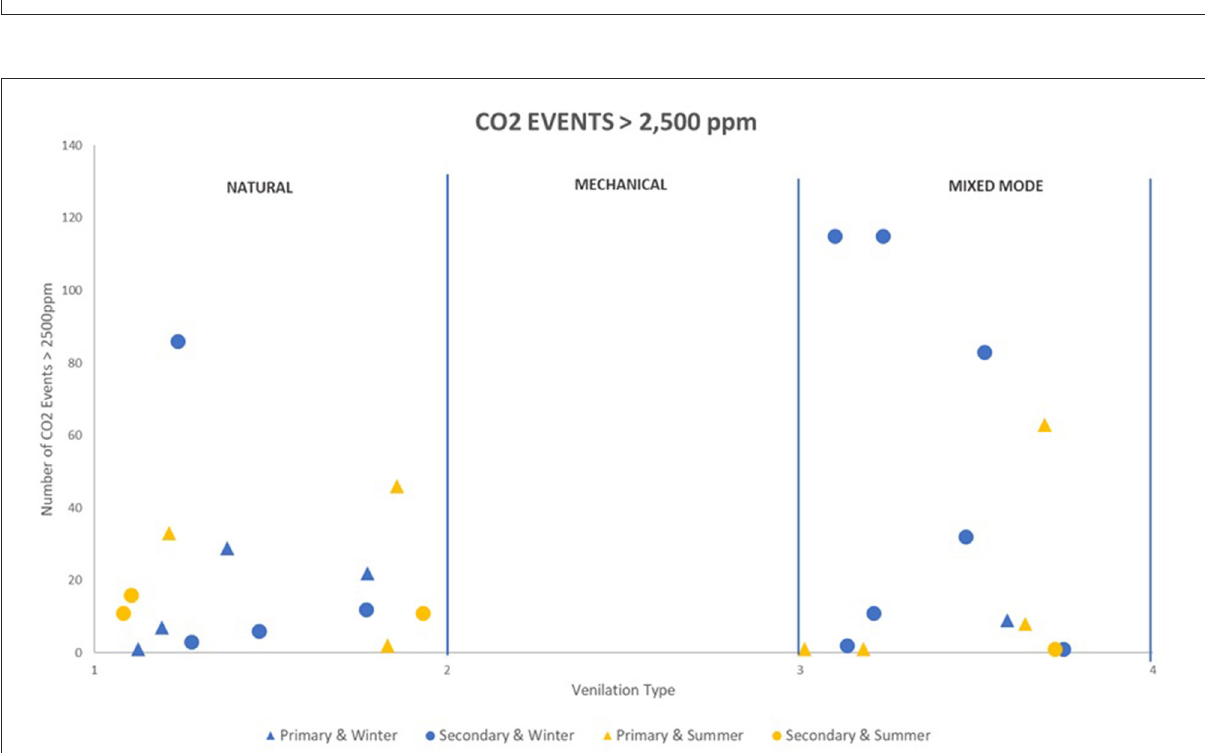
FIGURE4 Incidence of > 1,800 ppm exceedances with ventilation type, primary/secondary classroom type and the season which the monitoring was conducted. Winter: 01 May − 31 August, Summer: all other times of the year.